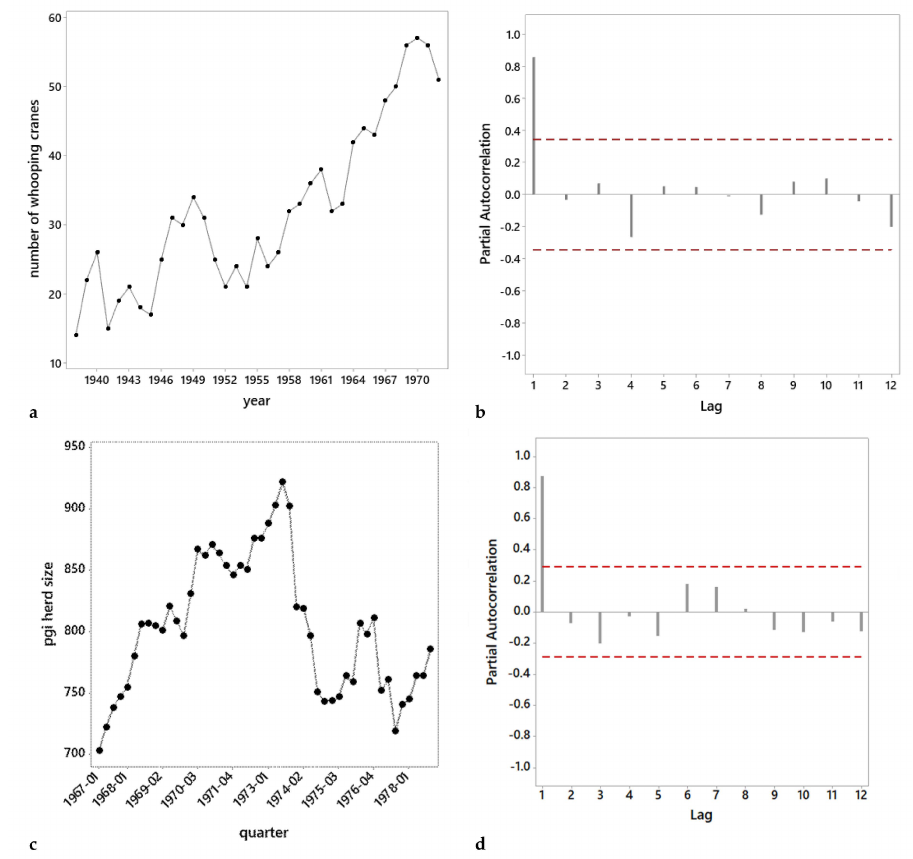
Figure 2. Time series and partial temporal autocorrelation correlogram (with 95% confidence intervals denoted by red dashed lines) plots for selected publicly available datasets. Top left ( a ): a count of whooping cranes arriving in Texas each autumn, from Hand et al. [19], Table 121. Top right ( b ): Figure 2a correlogram. Bottom left ( c ): United Kingdom pig herd size data, from Andrews and Herzberg [17], Table 62.1. Bottom right ( d ): Figure 2c